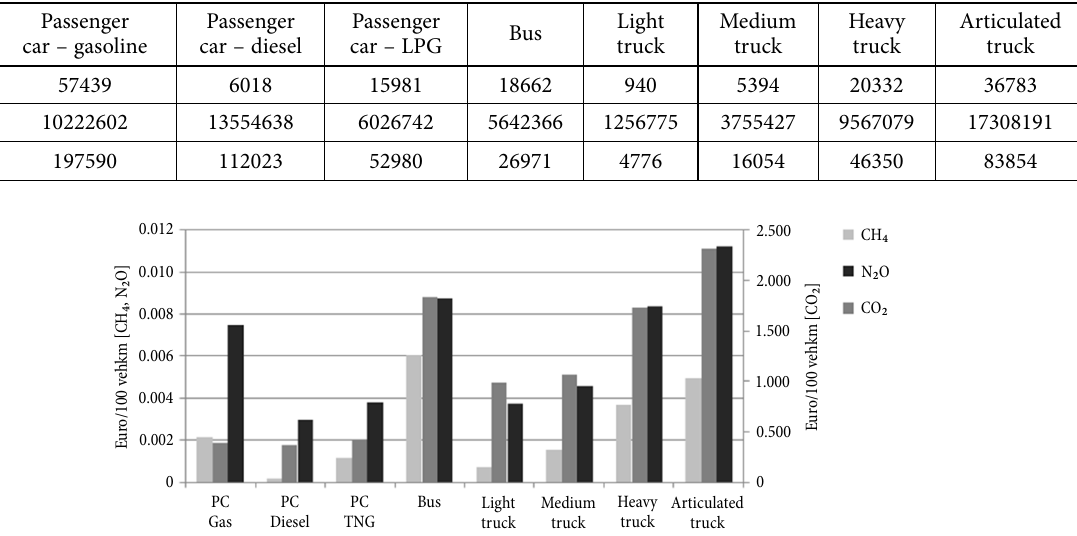
Table 3. Total GHG emission cost of different vehicle categories on the observed road network [€/year]